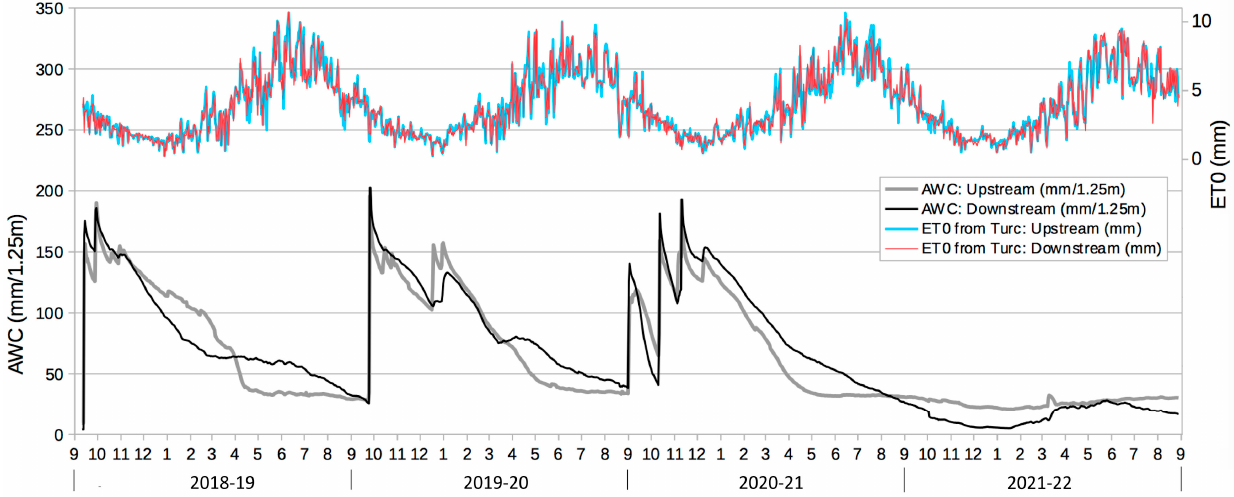
Figure 10. Evolution of available water content (AWC) in upstream and downstream Jessour soil pro fi les and evapotranspiration (ET0). profiles and evapotranspiration